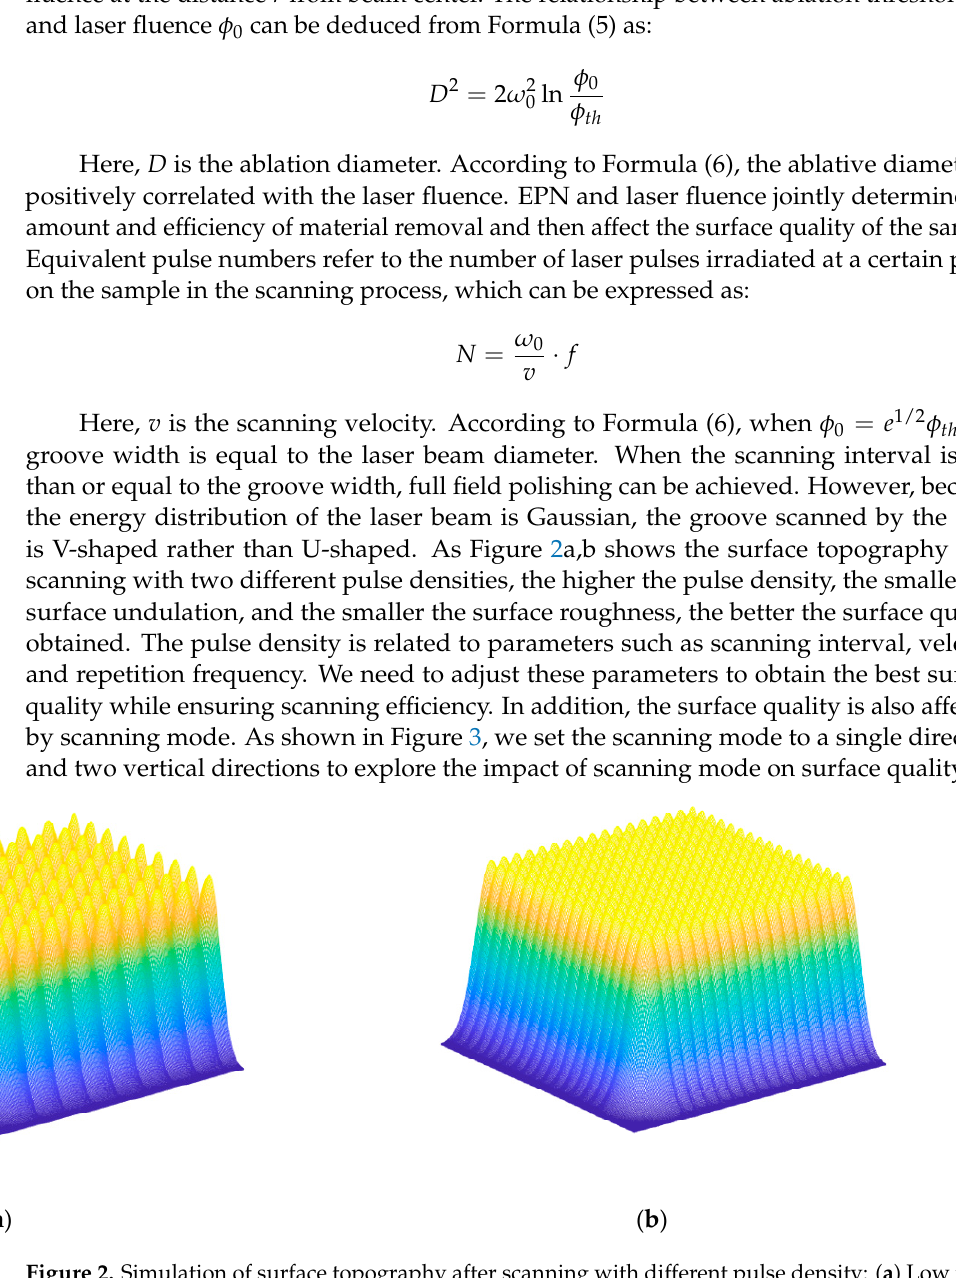
Figure 3. Schematic diagram of path planning for femtosecond laser polishing. In addition to some experimental parameters described above that may affect the polishing effect, underwater femtosecond laser processing [27], inert gas atmosphere femtosecond laser processing [28], water-jet-guided laser processing [29], and other pro- cessing methods have also been studied in depth. Different processing environments will also have an impact on surface quality. In this paper, in order to reduce the requirements of the processing environment, experiments in the above environment are not conducted. In the introduction, we mentioned that both pulse duration and repetition frequency have an effect on the polishing effect, and this effect is different for different materials [18]. In this experiment, the limitations of the experimental equipment do not allow us to ana- lyze their effects, so we set these two parameters to constant values. 3. Results 3.1. Ablation Threshold of Silicon Carbide According to TTM in Section 2.2, prior to the experiment, the ablation threshold of SiC was calculated to ensure that the femtosecond laser could be used for polishing. RB- SiC is a kind of highly dense material obtained by pressing fine particles of SiC and C bonding agent in a certain ratio into a billet and fully reacting with liquid silicon or vapor-